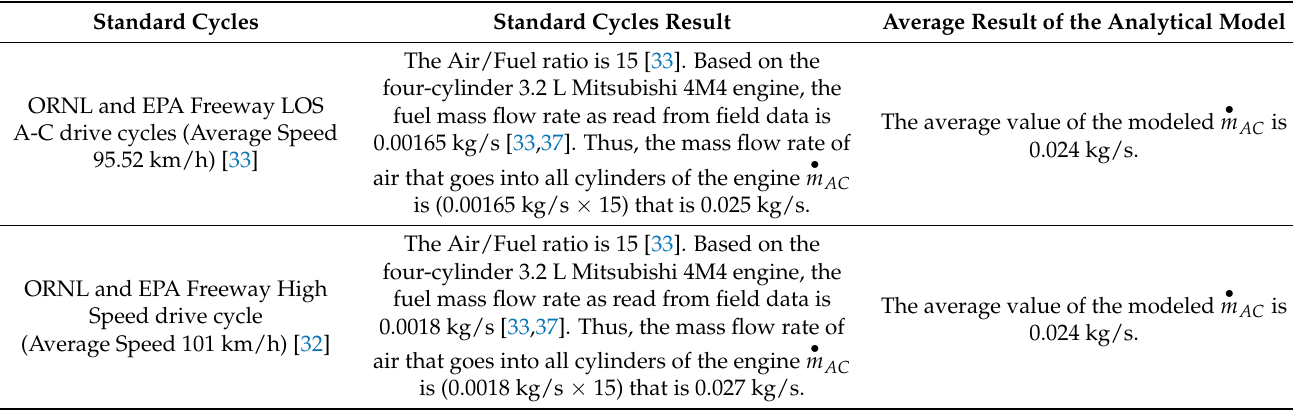
Table 4. Comparison of the modeling results and the results of standard cycles on